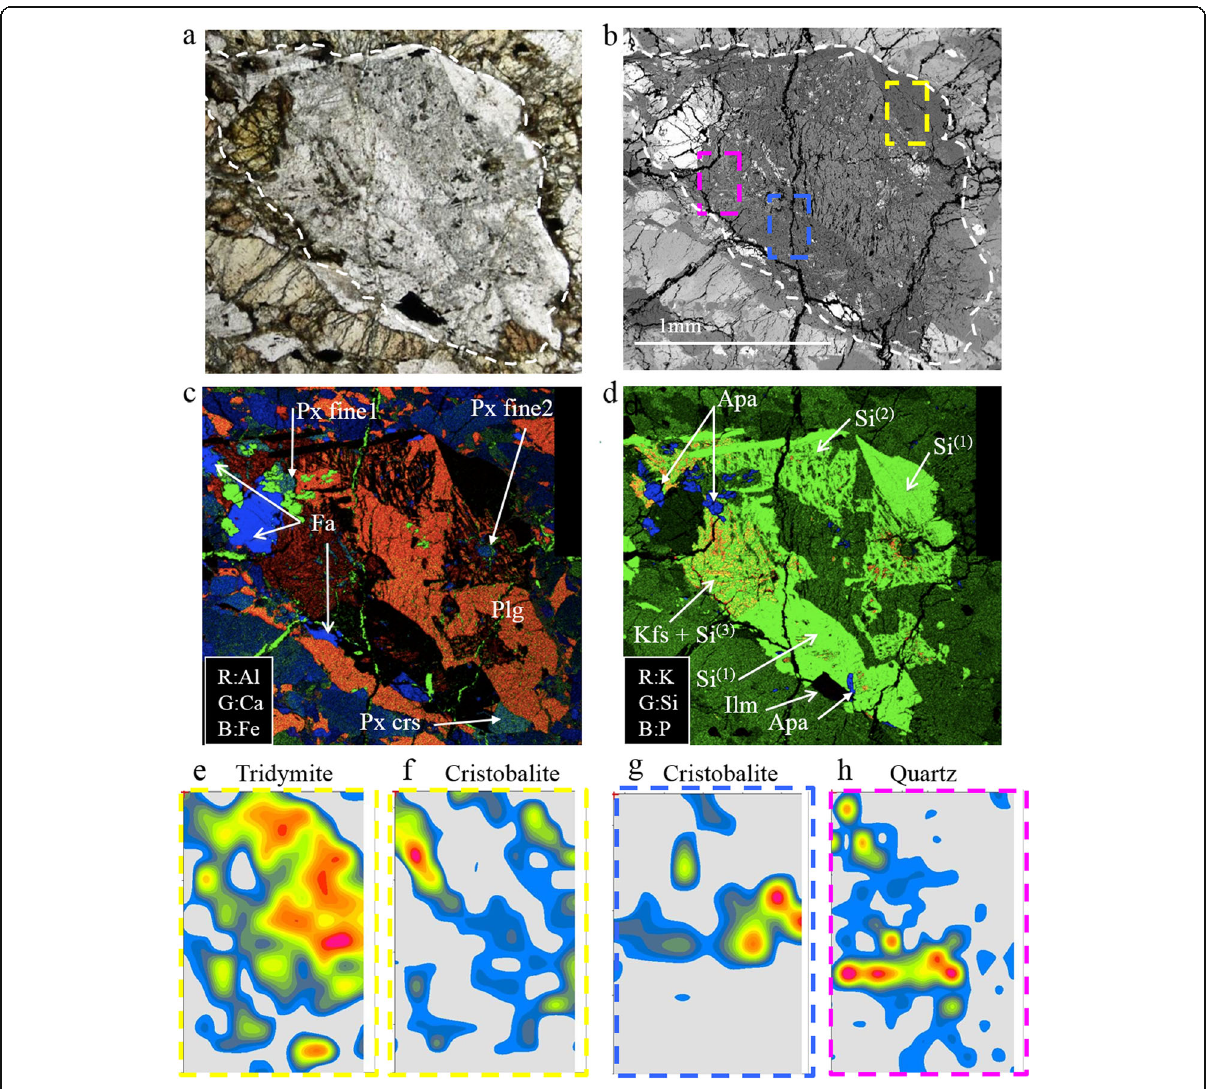
Fig. 3 Images of silicic clast and Raman maps showing silica polymorphs. Detailed explanations of each figure are as follows: a photomicrograph in plane polarized light; b back-scattered electrons (BSE); c RGB elemental map with R=Al, G=Ca, B=Fe, d RGB image with R=K, G=Si, B=P. Silica occurs as: (1) massive to elongate grains; (2) narrow domains enveloping thin plagioclase feldspar laths; and (3) elongate crystals intercalated with K-Ba-feldspar. Areas where Raman peaks were mapped are color-coded in panel b , with maps e , f enclosed in the yellow box, map g in the blue box, and map h in the purple box. The Raman peak intensity maps show the following peaks: e peak intensity at 351 cm − 1 (tridymite); f peak intensity at 411 cm − 1 (cristobalite); g peak intensity at 411 cm − 1 (cristobalite); h peak intensity at 464 cm − 1 (quartz). Warm colors (red) indicate high peak intensities and dark (blue)